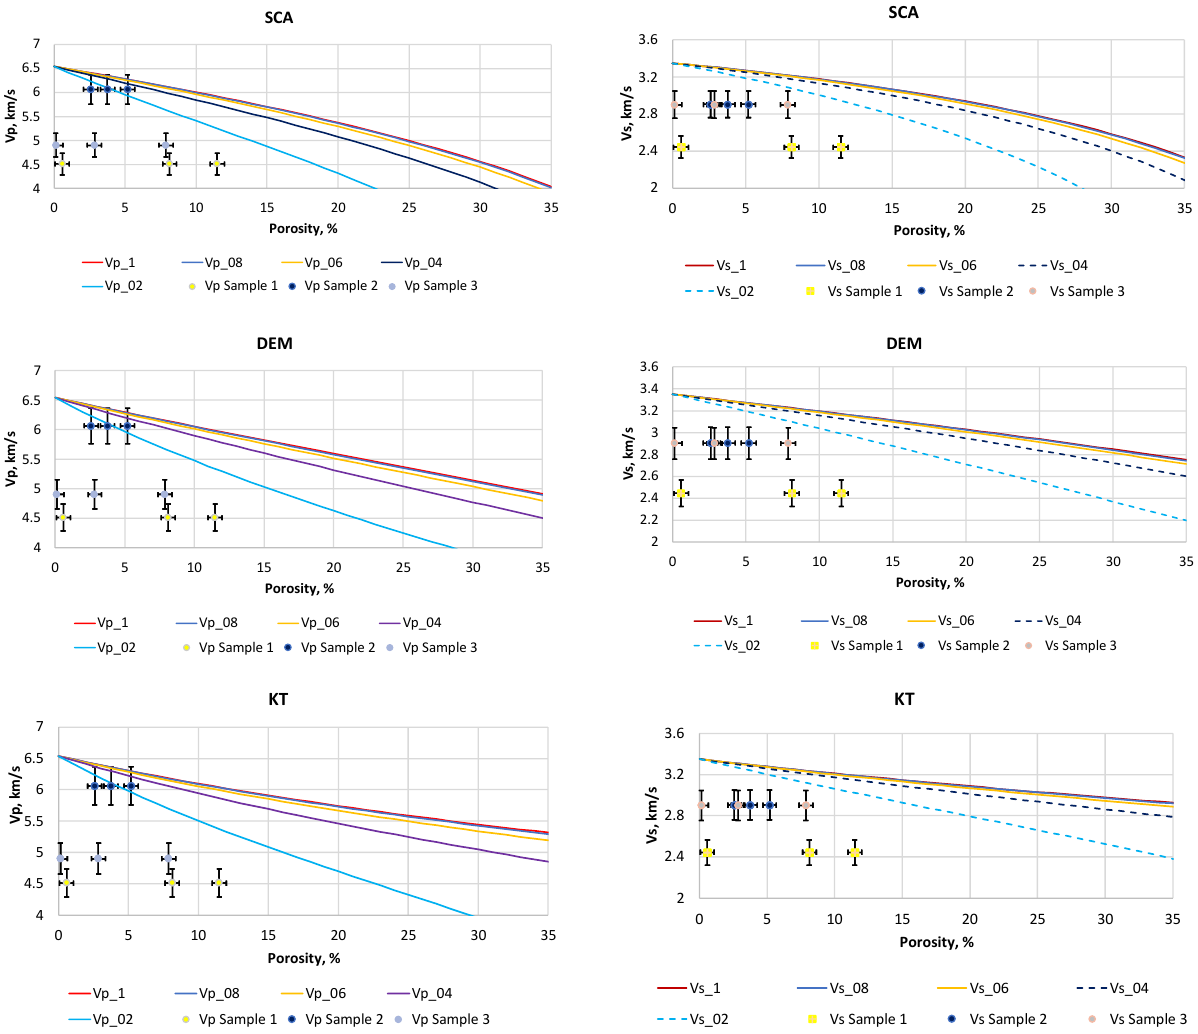
Figure 8. Elastic wave velocities as a function of porosity for an isotropic model of a calcite matrix with pores of various shapes. The aspect ratio of the pores varies from 0.2 to 1. SCA is the self-consistent method, DEM is the differential scheme, and KT is the Kuster–Toksöz method. Experimental velocities Vp and Vs obtained for Samples 1–3 are shown by circles of different colors.